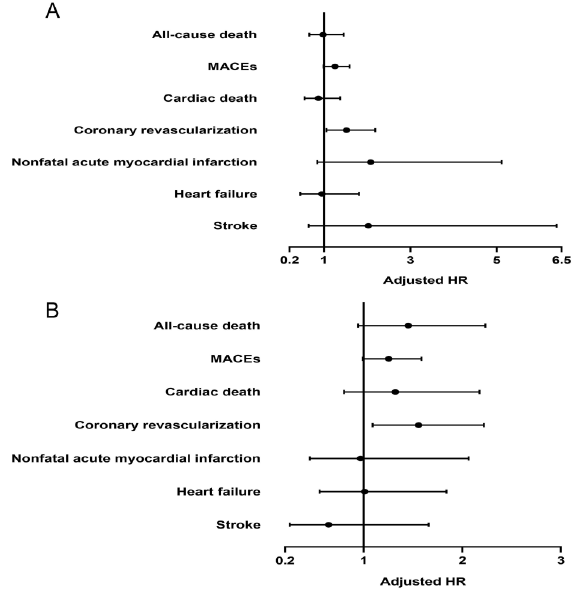
Figure 2. Forest plots for multivariate Cox regression analysis of the LDL/HDL ratio and clinical endpoints. A , High LDL/HDL compared with low LDL/HDL; B , High LDL/HDL compared with medium LDL/HDL. LDL: low-density lipoprotein; HDL: high-density lipoprotein; MACEs: major adverse cardiovascular events.